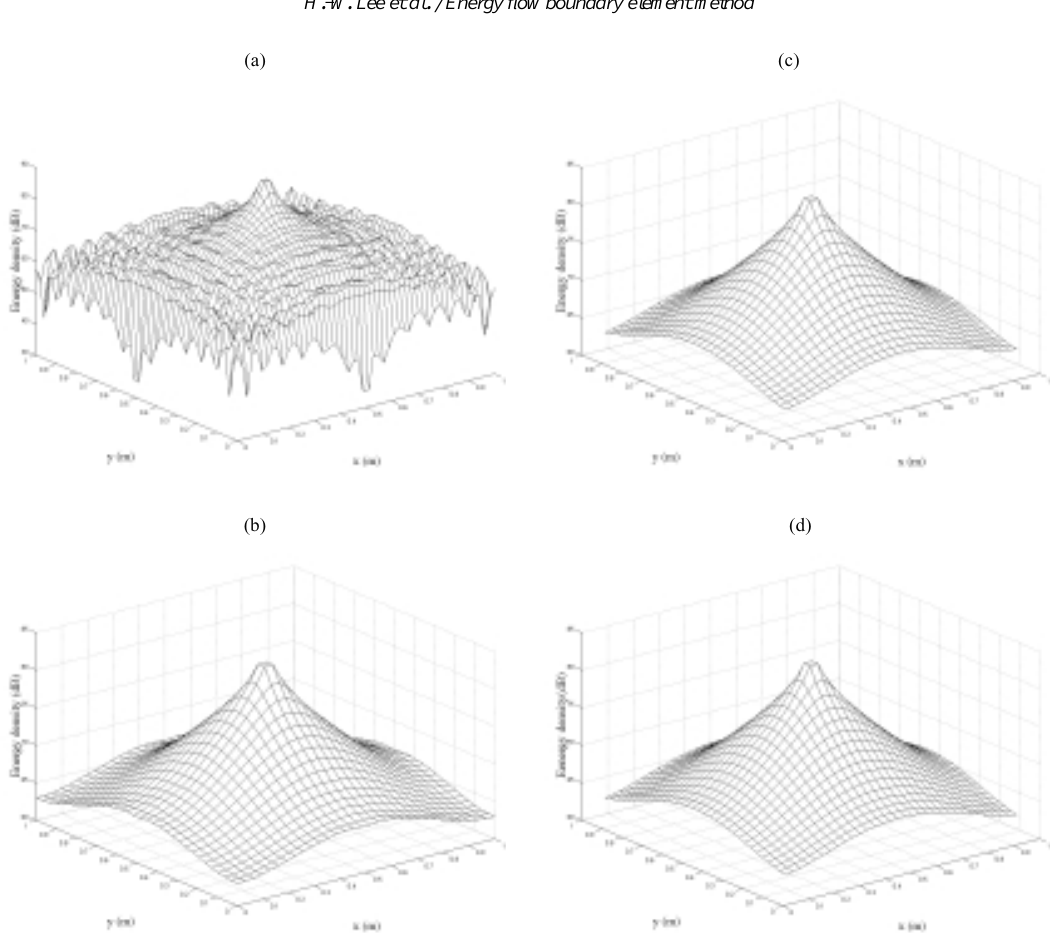
Fig. 5. The energy density distributions in rectangular plate predicted by (a) classical solution, (b) EFA analytic solution, (c) direct EFBEM solution, (d) indirect EFBEM solution when f = 1 kHz and η = 0 . 2 . The reference energy density is 1 × 10 − 12 J/m 2 . (cid:24)ξ i i th boundary element, ∆Γ is the length of the j th boundary where 0 is the position vector of the midpoint of the element, (cid:24)z k is the position vector of the midpoint of the k th internal cell, and ∆Ω is the area of the k th internal cell. Thus, Γ and Ω are approximated by N boundary segments and M internal cells, respectively. The intensity obtained from Eq. (25) can be expressed in the same way as Eq. (28). Equations (26) and (27) of the indirect EFBEM are rewritten as Eqs (29) and (30) by discretization: N (cid:10) e ( (cid:24)x i ) = 0